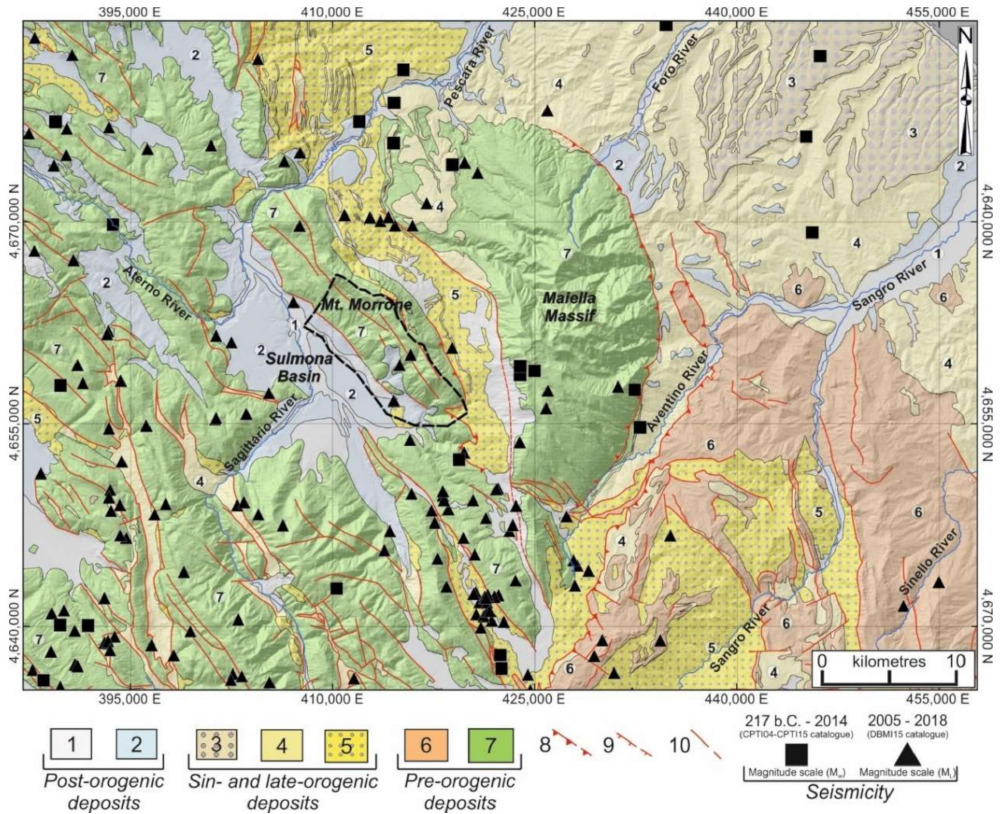
Figure 2. Geological scheme of central-eastern Abruzzo (modified from D’Alessandro et al. [31]) and the location of the study area (black dashed line). Legend: post-orogenic deposits—(1) fluvial deposits (Holocene), (2) fluvial and alluvial fan deposits (Middle-Late Pleistocene); sin- and late-orogenic deposits—(3) marine to continental transitional sequences (Early Pleistocene), (4) hemipelagic sequences with conglomerate levels (Late Pliocene–Early Pleistocene), (5) turbiditic foredeep sequences (Late Miocene–Early Pliocene); pre-orogenic deposits—(6) pelagic sequences (Oligocene–Miocene), (7) carbonate platform, slope and pelagic basin sequences (Jurassic–Miocene); (8) major thrust (dashed if buried); (9) major normal fault (dashed if buried); (10) major fault with strike-slip or reverse component (dashed if buried); seismicity—CPTI04 [32]-CPTI15 [33] catalogue (black square); DBMI15 [34] catalogue (black